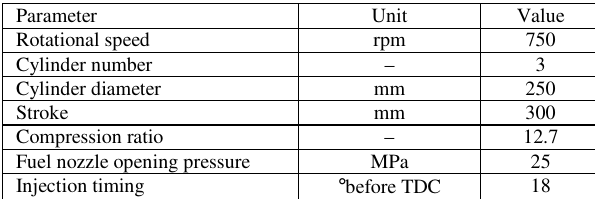
Table 2. AL25/30 engine parameters